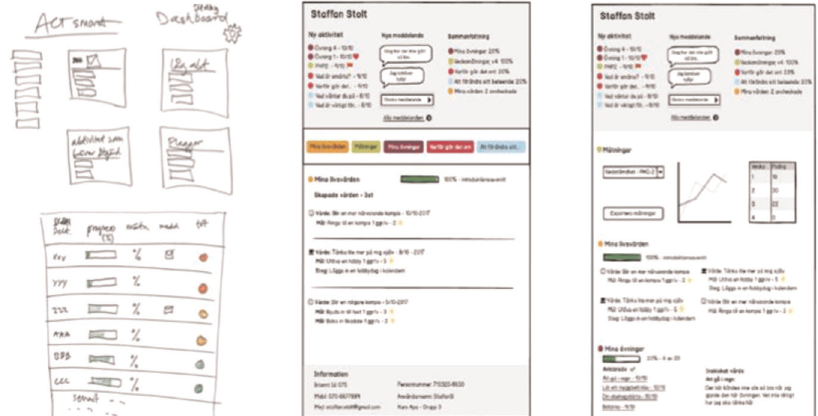
Fig. 7 Paper sketches showing the evolution of the list of patients in active treatment in the therapist interface during alpha